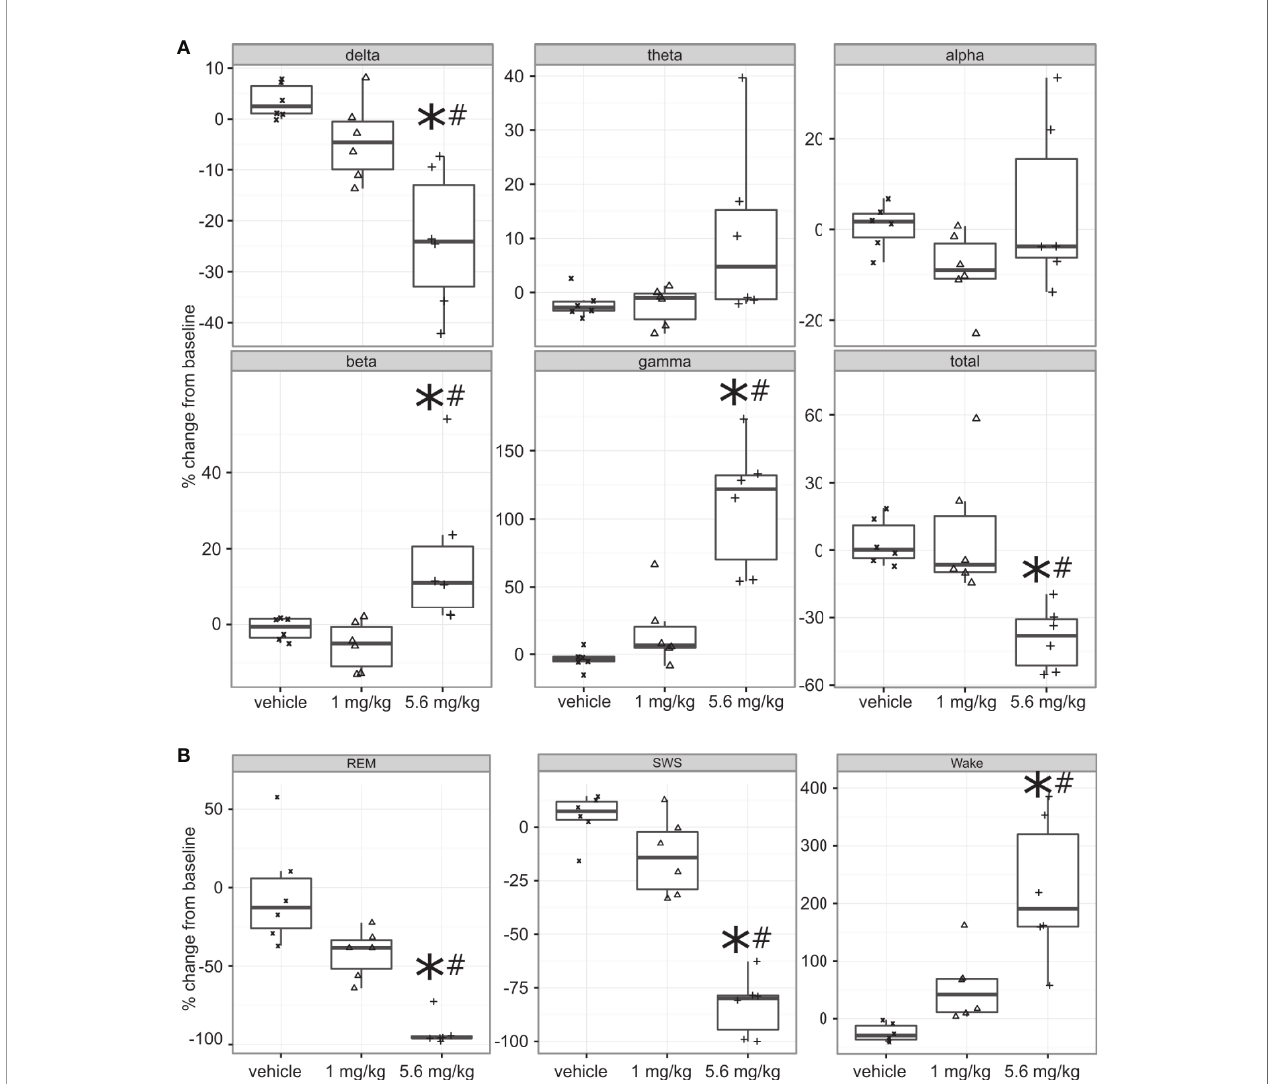
FIGURE 3 | Quantitative electroencephalography and polysomnography analysis of treatment with PF-6142. (A) Systemic PF-6142 treatment signi fi cantly and dose dependently modulates oscillatory power in freely moving rats. Vehicle or PF-6142 (low: 1.0 mg/kg, high: 5.6 mg/kg, SC) was administered in the morning during the inactive period of the animals in their home cage. Delta (0.5 – 4 Hz), theta (4 – 9 Hz), alpha (9 – 13 Hz), beta (13 – 28 Hz), and gamma (28 – 80 Hz) oscillation power was analyzed during the fi rst 4 h following treatment together with the total power contained in the signal. Statistical analyses revealed that treatment only with the high dose resulted in signi fi cant (* p < 0.05 vs. vehicle, # p < 0.05 vs. low) decrease of delta and total powers and increase of beta and gamma powers. Symbols (x for vehicle, D for low, and + for high dose) show values for individual animals. All animals are shown, outliers are not indicated separately, the upper and lower hinges on the boxplots show the 25 th and the 75 th percentiles, respectively, horizontal bar in the boxplot shows median value, whiskers extend to the minimum and the maximum values. (B) Systemic PF-6142 treatment signi fi cantly and dose dependently increases the time spent in wakefulness in freely moving rats. The fraction of time rats spent awake (Wake), in slow-wave sleep (SWS), or in REM sleep during the fi rst 4 h following treatment were analyzed. Statistical analyses revealed that treatment with the high dose (5.6 mg/kg, SC) resulted in a signi fi cant (* p < 0.05 vs. vehicle, # p < 0.05 vs. low) decrease of the time spent in SWS and REM sleep, and an increase of the time spent awake. Boxplots are set up as described in (A)